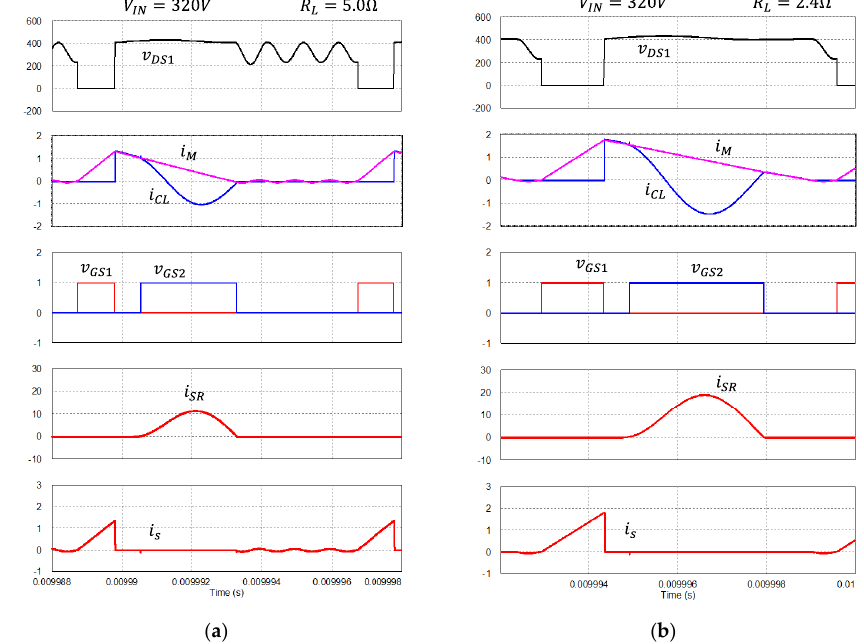
Figure 14. Steady-state waveform result of QR flyback converter with SDAS with PSIM simulation: ( a ) under low power load; ( b ) under large power load.